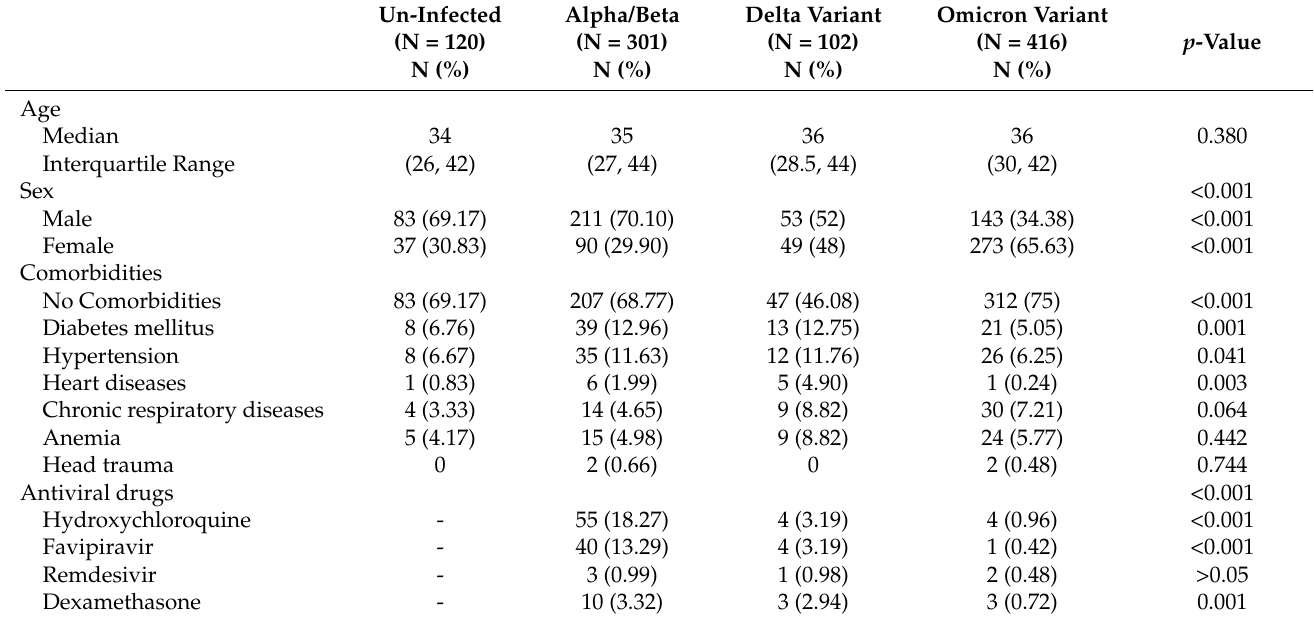
Table 1. Demographic, co-morbidities, and clinical characteristics of un-infected (n = 120) and COVID- 19 infected participants when alpha/beta (n = 301), delta (n = 101), and omicron (n = 416) variants were dominant.